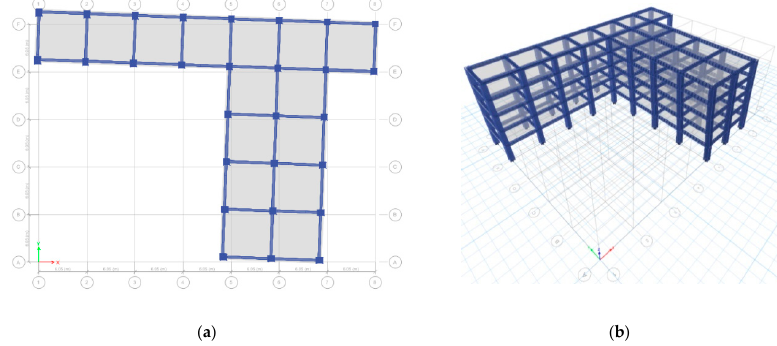
Figure 7. The 1st mode shape for T 1 = 0.480 s: ( a ) plane view, and ( b ) 3D view.